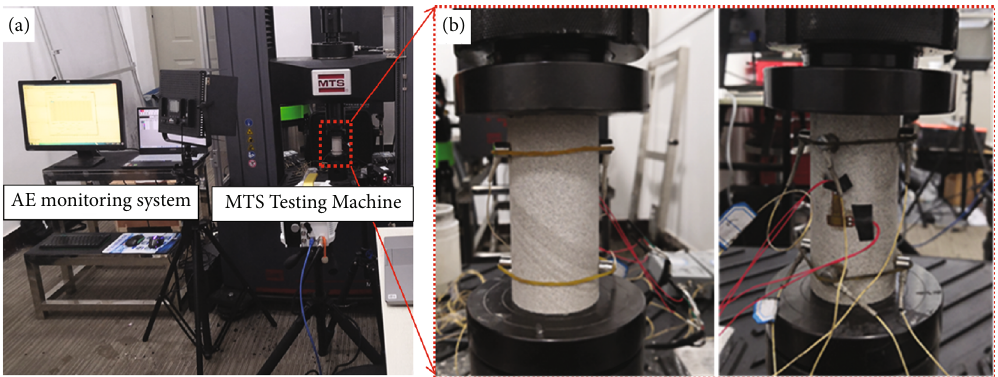
Figure 3: Test system: (a) experimental equipment and (b) arrangement of AE